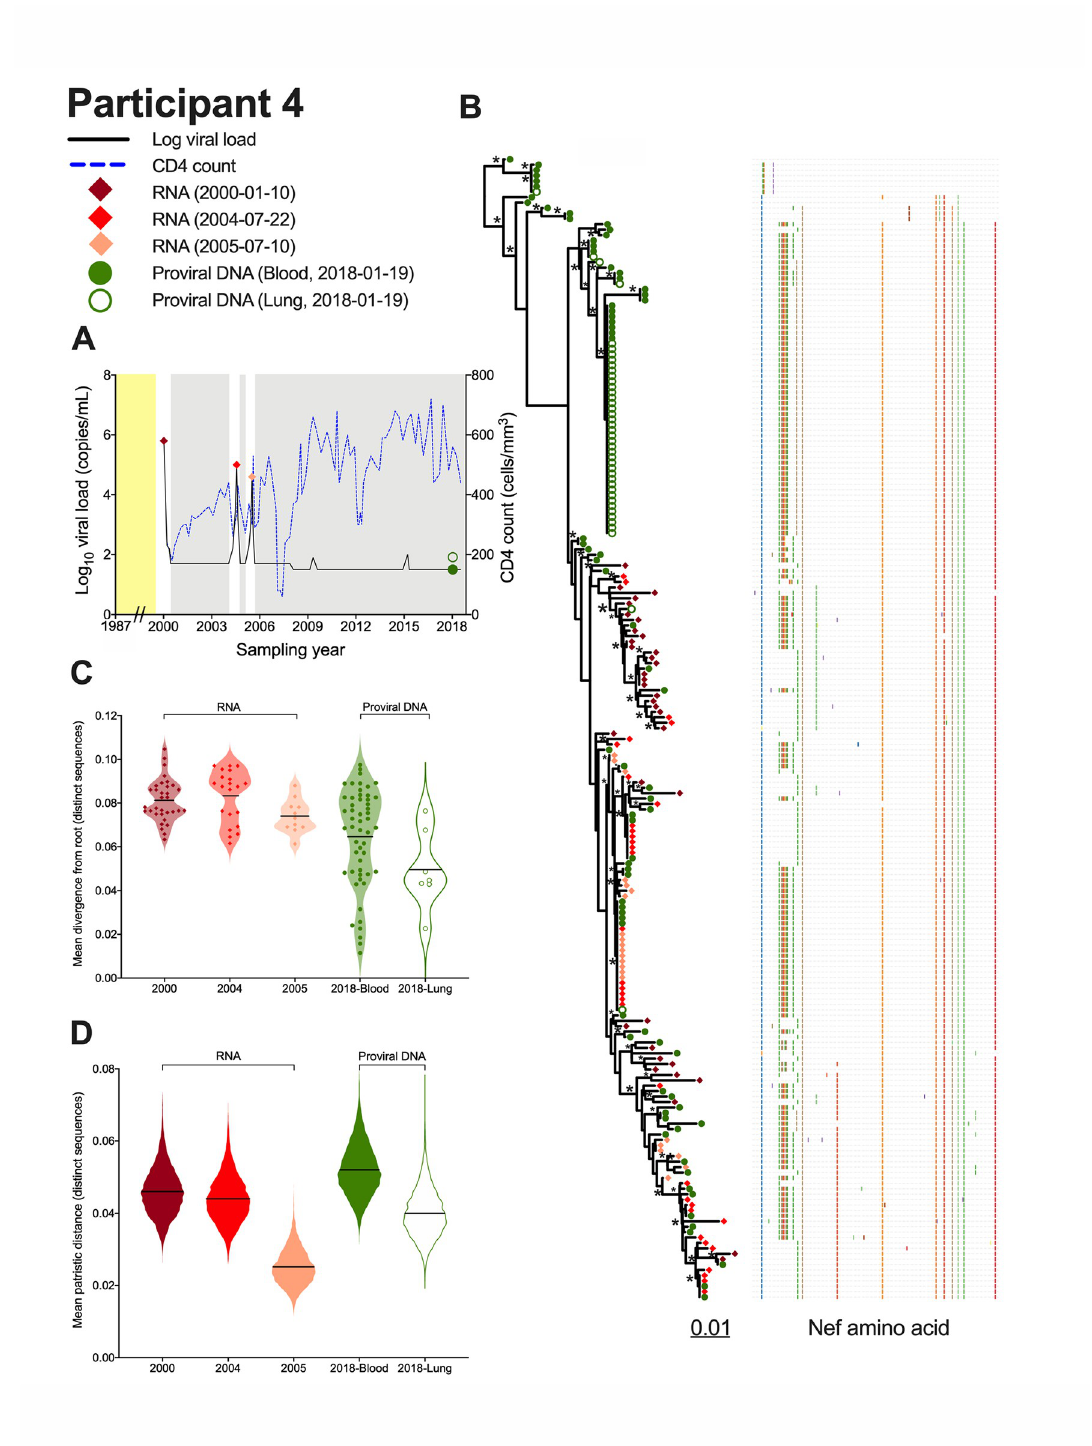
Fig 6. Interpreting proviral diversity in context of prior within-host HIV evolution: participant 4. (A) Plasma viral load (solid black line), CD4 + T-cell count (dashed blue line) and samples analyzed (colored diamonds and circles). Yellow shading denotes period following infection where no clinical information is available. Grey shading denotes periods of suppressive ART. (B) Highest likelihood phylogeny derived from Bayesian inference, outgroup rooted. Scale shows estimated substitutions per nucleotide site. The adjacent plot shows amino acid diversity, with coloured ticks denoting non-synonymous substitutions with respect to the reference sequence at the